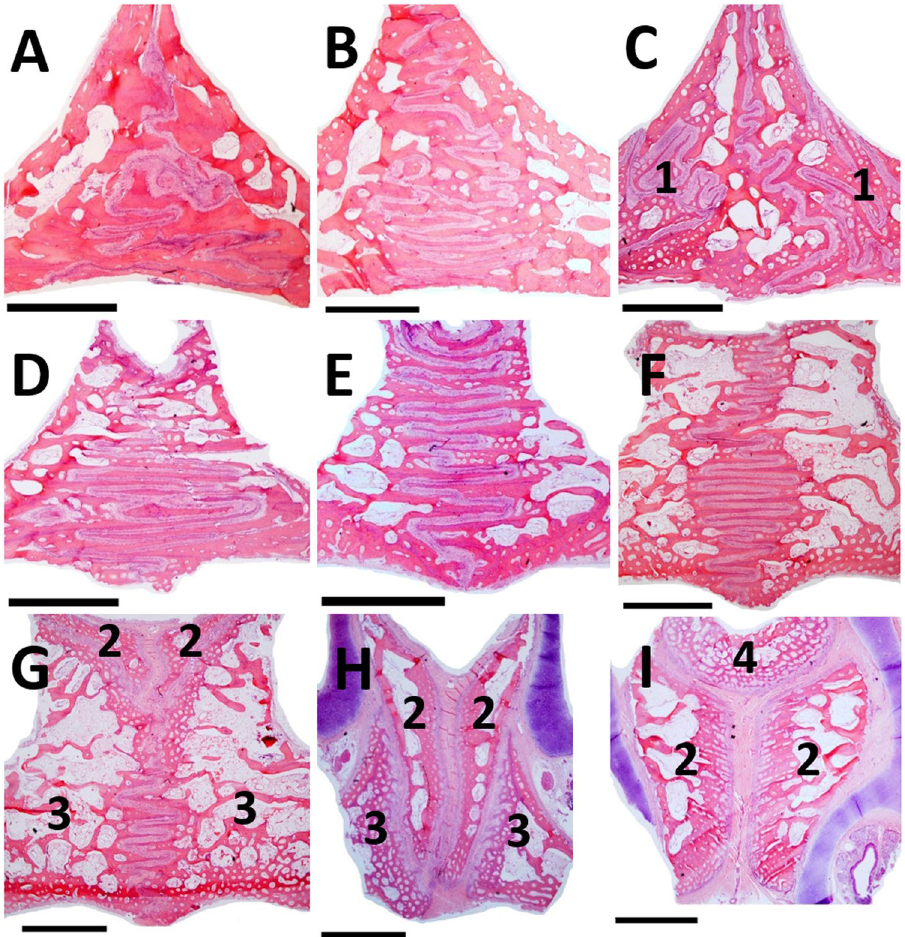
plane (rostro-caudal view). Irregular shape in the palato-palatine suture ( A – C ) and maxillo-palatal sutures on the sides (1); serrated pattern of the maxillo-maxillary suture ( D–F ); overlapping of different structures in the premaxillary region ( G – I ), including the premaxillo-premaxillary suture (2), the maxillo-maxillary suture (3), and the premaxillo-vomeral suture